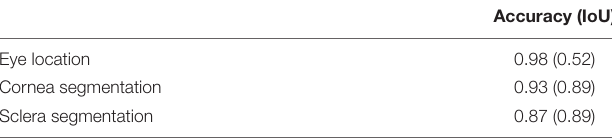
TABLE 3 | Accuracy of Modules I and II.